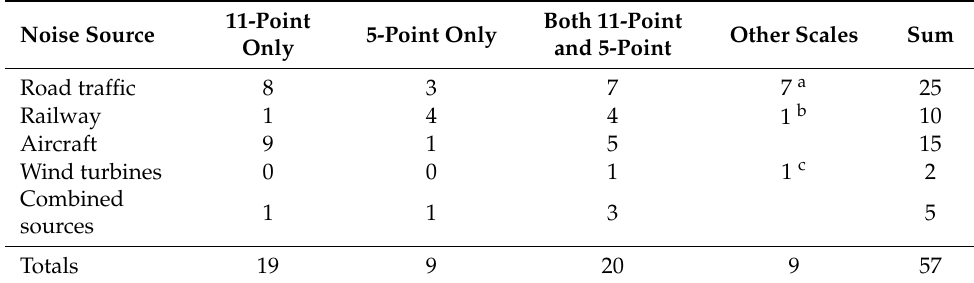
Table 1. Number of times either the 5-point, 11-point, or both annoyance scales, as well as other scale types, were used in the surveys included in the meta-analysis by Guski et al. [1]. Both 11-Point 11-Point Other Scales 5-Point Only Noise Source and 5-Point Only